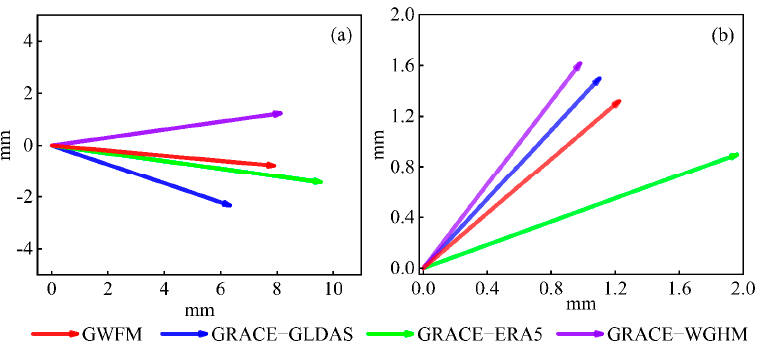
Figure 7. Vector diagram of the GWSA amplitude and phase change from 2003 to 2016. ( a ) Annual; ( b ) semi-annual. ( b )